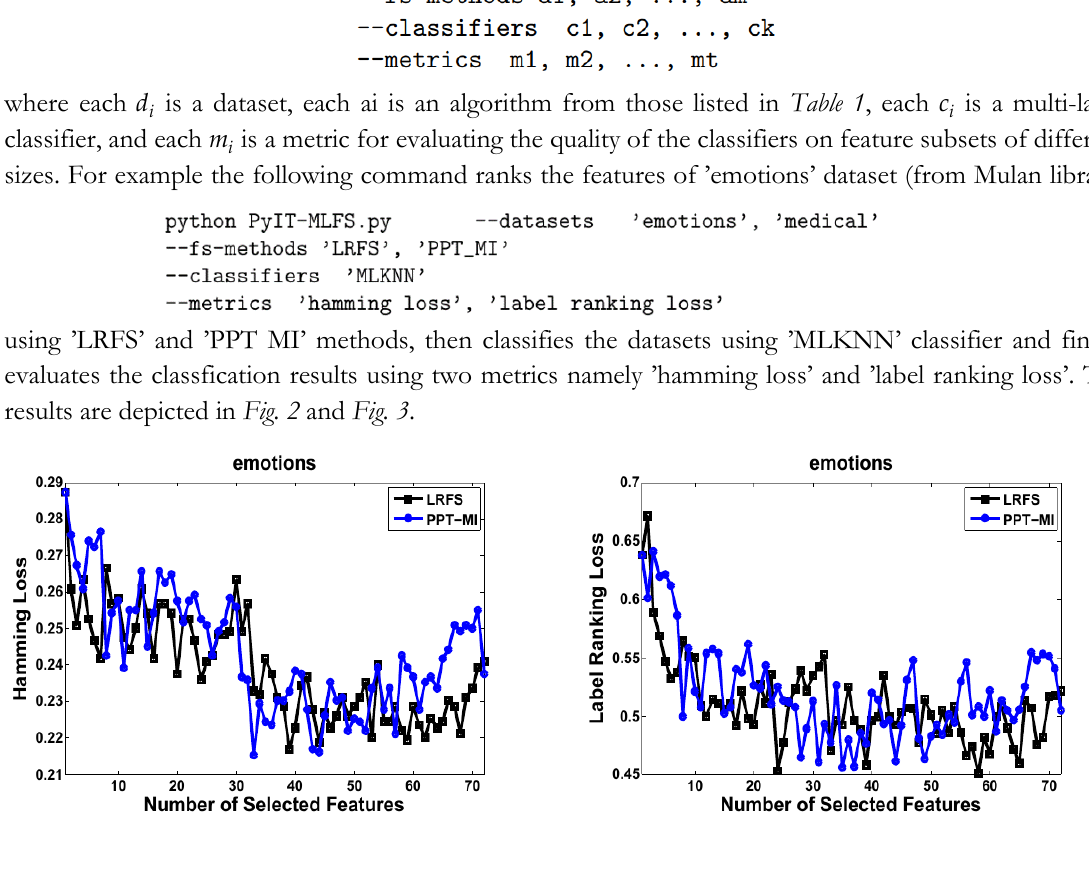
Fig. 2. The results on emotions dataset (left) hamming loss, (right) label ranking loss. The running times to rank all the features using LRFS and PPT-MI are 14 and 4 seconds, respectively.